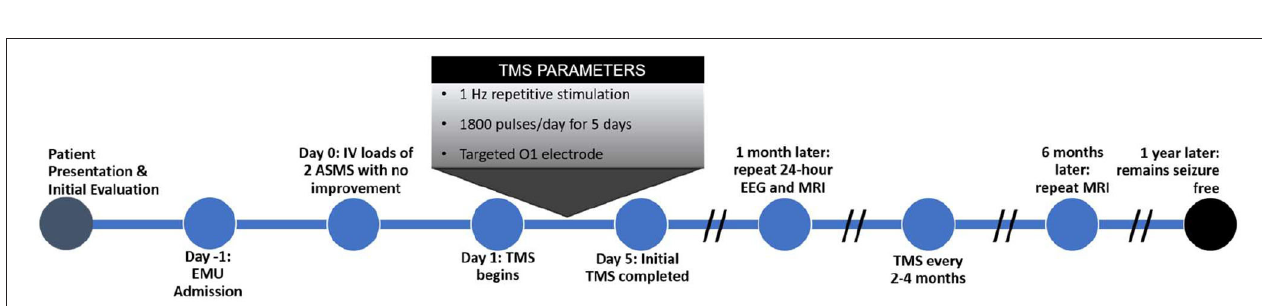
FIGURE 3 | Spectral power density and ratios. Median spectral power density and power ratios. (A) Median spectral power density across all channels. There is an inflection point around 2Hz, with lower frequencies showing more power after stimulation initiation. (B) Ratio of slow delta activity to faster delta activity, showing a significant increase in median power by the end of stimulation as compared to prior. (C) Broadband power, again showing a significant difference in median by the end of stimulation therapy as compared to before. Asterisks indicate statistical significance by Wilcoxon rank-sum test as compared to prior to stimulation (day 0).